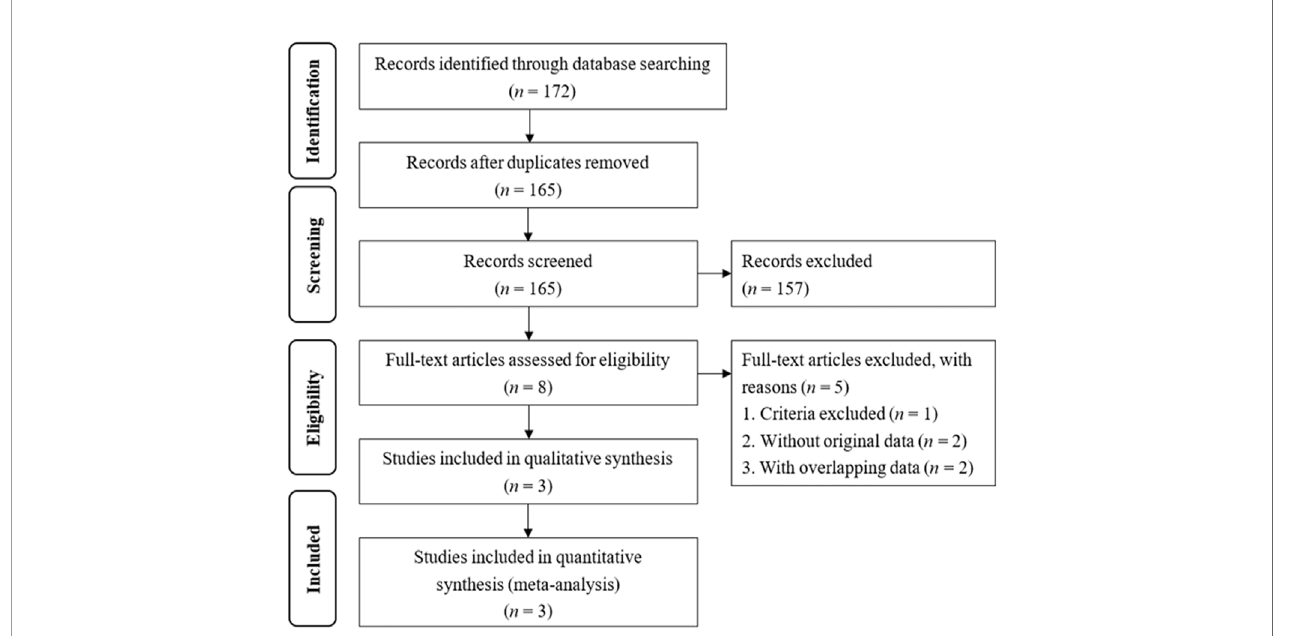
FIGURE 1 | Flow chart of the literature search. The 175 identi fi ed studies were from PubMed (11), Embase (152) and Cochrane